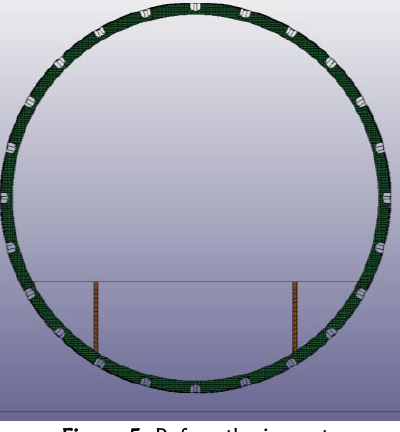
Figure 5: Before the impact